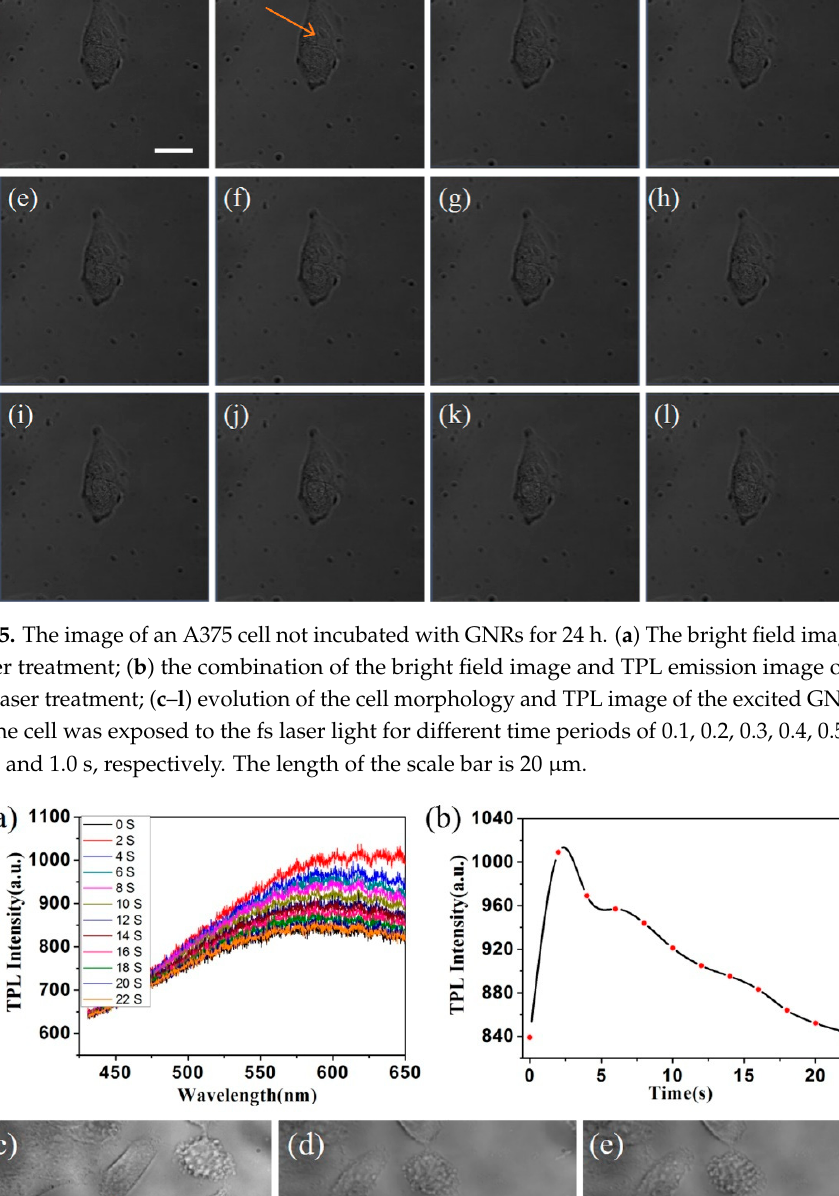
the laser treatment; ( b ) the combination of the bright field image and two-photon-absorption induced